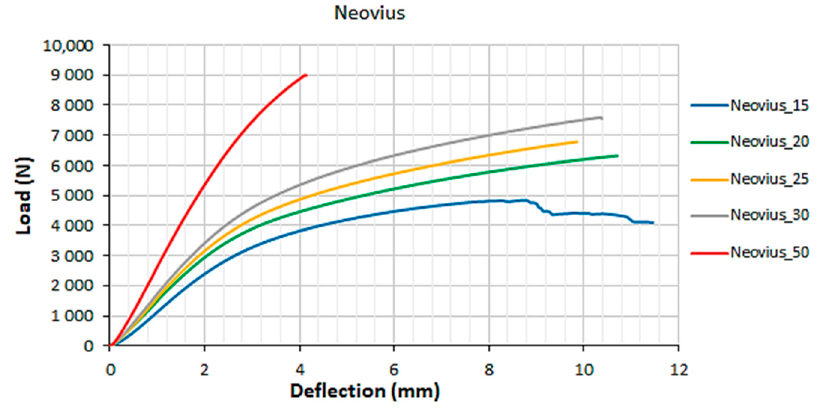
Figure 10. Load-deflection curves for 5 different relative weights of the Neovius structure. Figure 10. Load-de fl ection curves for 5 di ff erent relative weights of the Neovius structure.